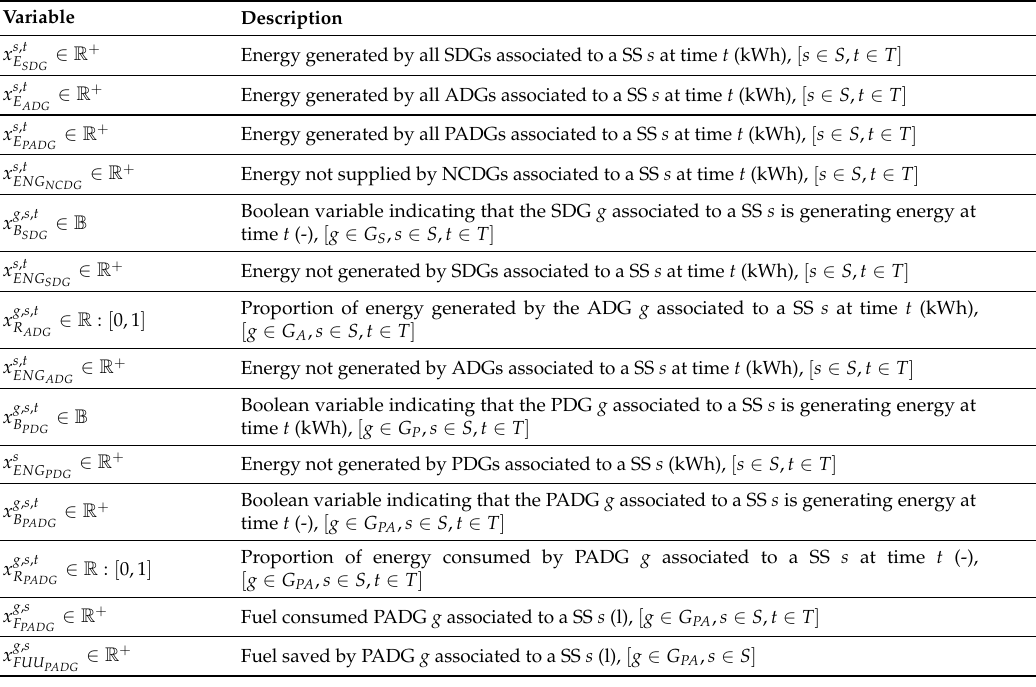
Table 9. Summary of variables (DG variables).